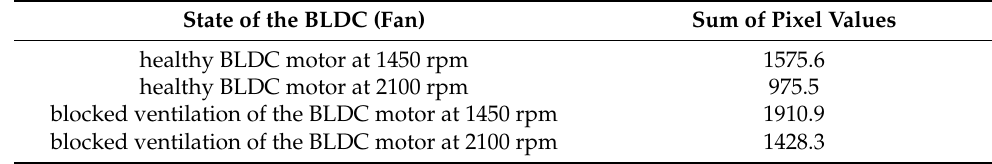
Table 1. Computed sums of pixel values for 4 differences (parameter p =